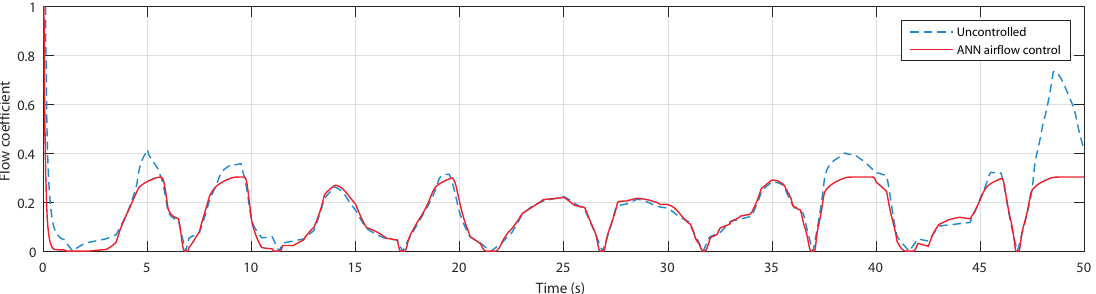
Figure 21. Flow coefficient for uncontrolled case and ANN-based airflow control. The torques shown in Figure 22 prove that the uncontrolled torque did indeed suffer from the stall effect at the same instants, but thanks to the airflow control, they were successfully avoided.